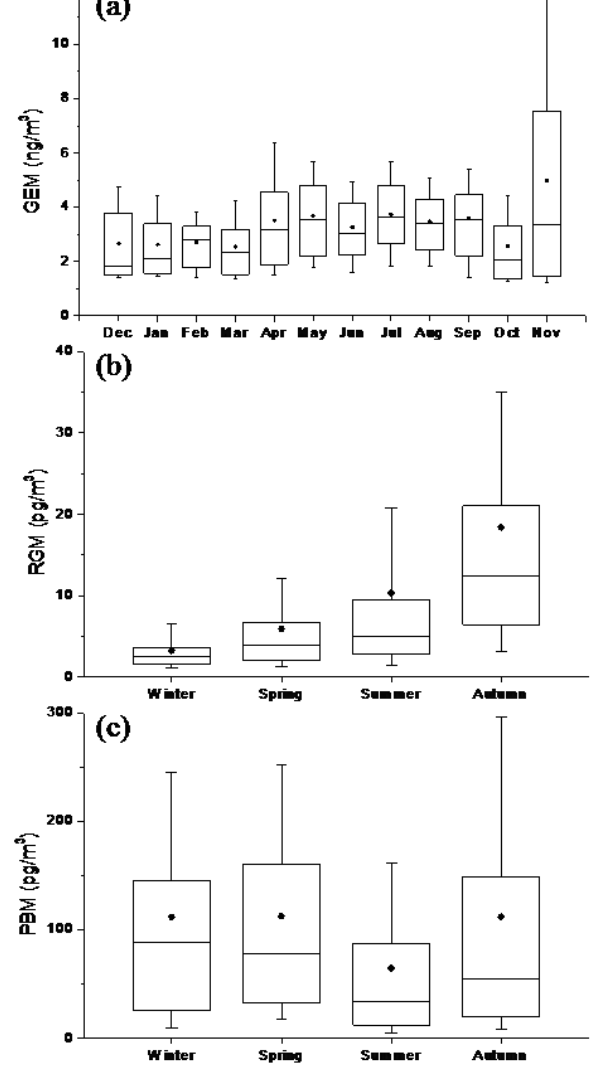
Fig. 3. Monthly variation of (a) GEM and seasonal variation of (b) RGM and (c) PBM concentration. Notes: the bottom and top of the box represent the 25th and 75th percentiles (the lower and upper quartiles), respectively. The band near the middle of the box rep- resents the 50th percentile (the median). The ends of the whiskers represent the 10th and 90th percentiles. The dots represent the mean